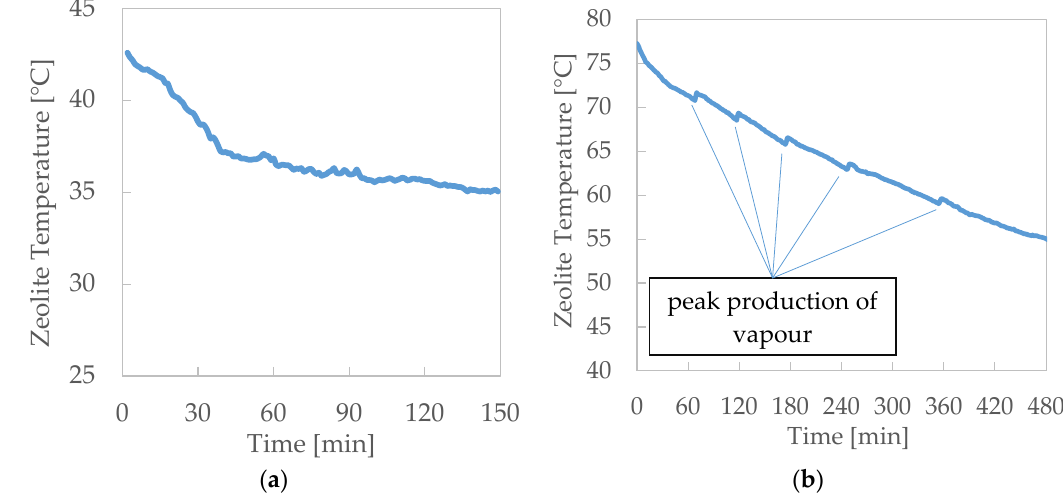
Figure 7. Adsorption results: zeolite temperatures during the test. ( a ) Adsorption—Test 4 and ( b ) Adsorption—Test 5.